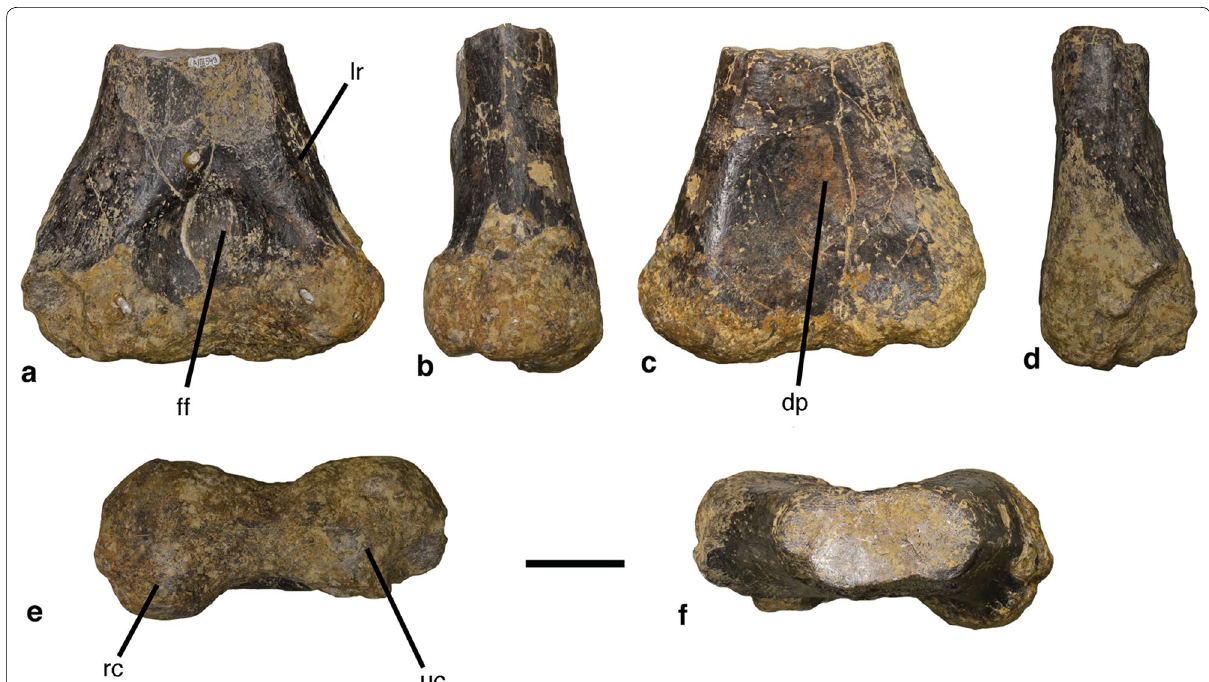
Fig. 8 Distal end of left humerus of Schleitheimia schutzi n. gen., n. sp., PIMUZ A/III 549. a anterior view; b lateral view; c posterior view; d medial view; e distal view; f , proximal view of proximal break. dp, posterior depression; ff, flexor fossa; lr, lateral ridge; rc, radial condyle; uc, ulnar condyle. Scale bar equals 5